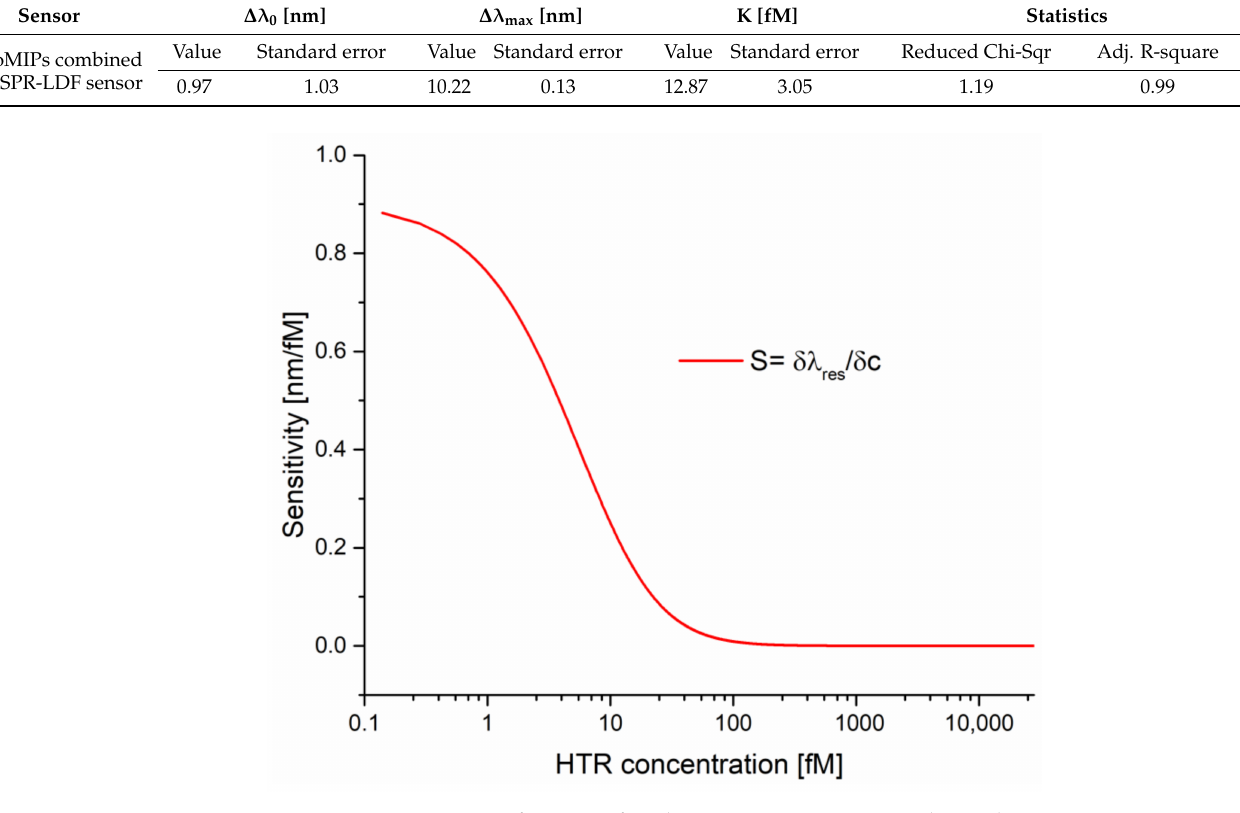
Figure 5. Sensitivity as a function of analyte concentration in semi-log scale.